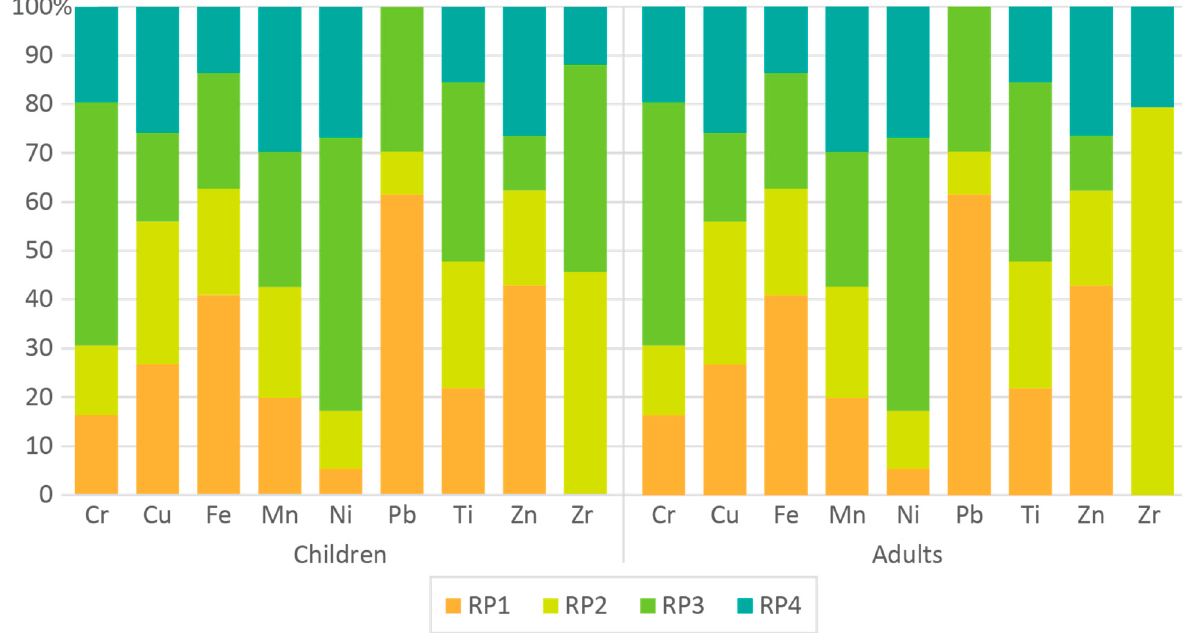
Figure 6. Targeted hazard quotient (THQ) in edible plants (relative quantification, in %). HI plant was similar to THQ, being >1 in all samples and higher for children (Figure 7), being ranked RP3 (6.41 × 10 2 to 4.27 × 10 2 ) > RP4 (3.68 × 10 2 to 2.45 × 10 2 ) > RP1 (3.59 × 10 2